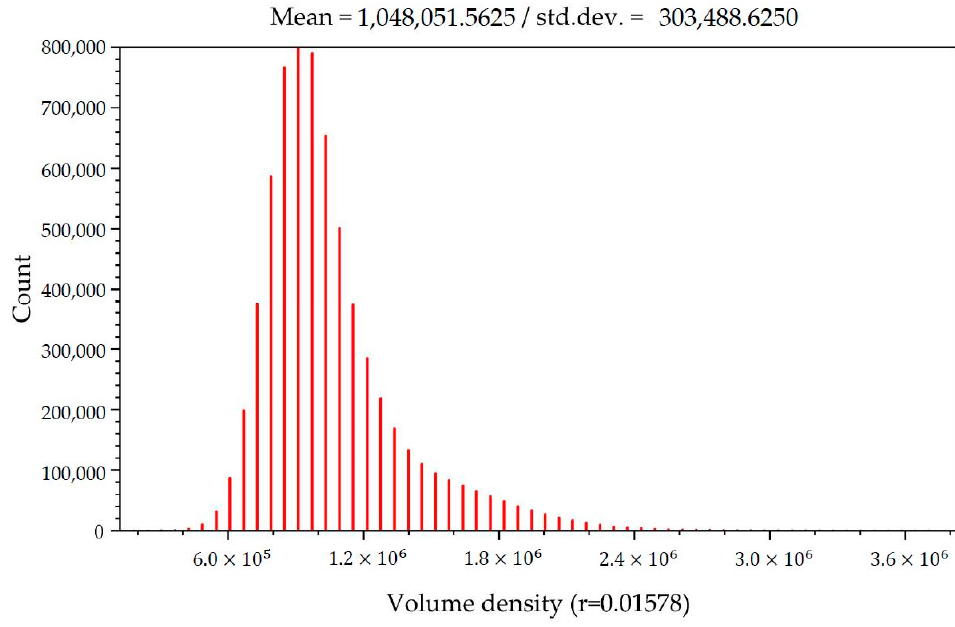
Figure 14. Density distribution result and the averaged volume density of Ofune-hoko.